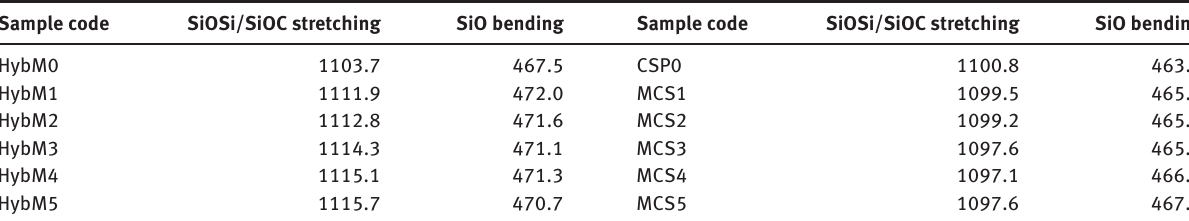
Table 1: Specific assignment in FTIR spectra of modified CSPs and hybrid nanocomposites. Sample